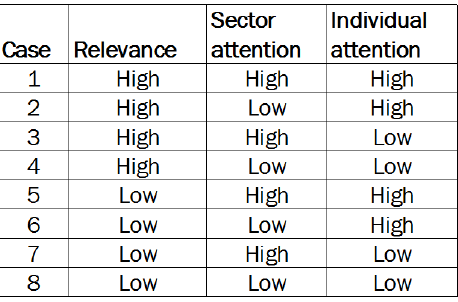
Table 2 Eight possible combinatorial consequences of the respondents’ opinions of the conditions in the construction